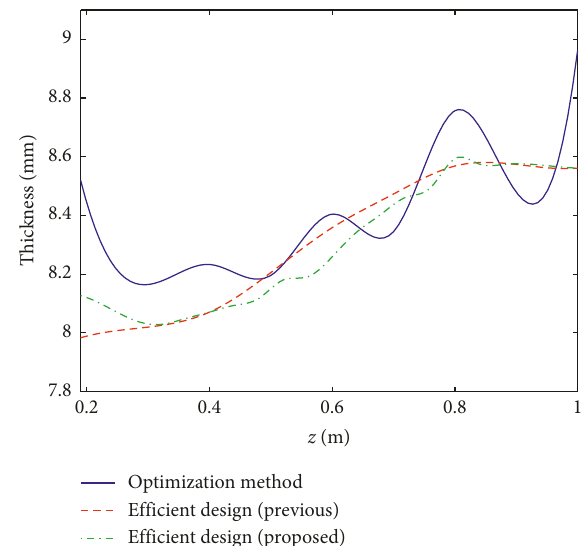
Figure 7: Thickness profile of VTRs obtained by different